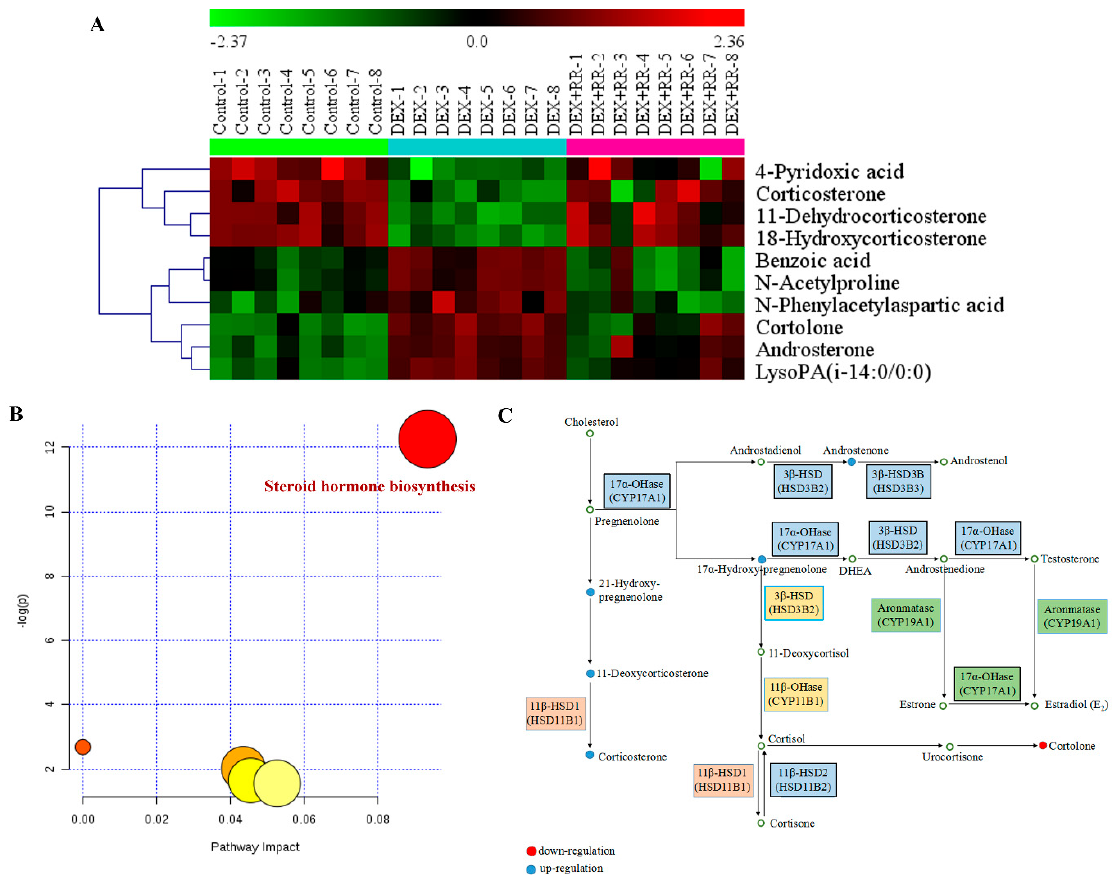
Figure 6. Heat map and metabolic pathway analysis based on the UHPLC-Q/TOF-MS profiling data for samples in the control, DEX, and DEX+RR groups. ( A ) Hierarchical clustering heat map of the differential metabolites before and after RR treatment in DEX-treated rats; ( B ) summary of ingenuity pathway analysis with MetPA. The size and color of each circle were based on pathway impact value and p -value, respectively; ( C ) construction of the metabolic pathway related to differential metabolites. The metabolites were labeled in blue (up-regulation after RR treatment) or red (down-regulation after RR